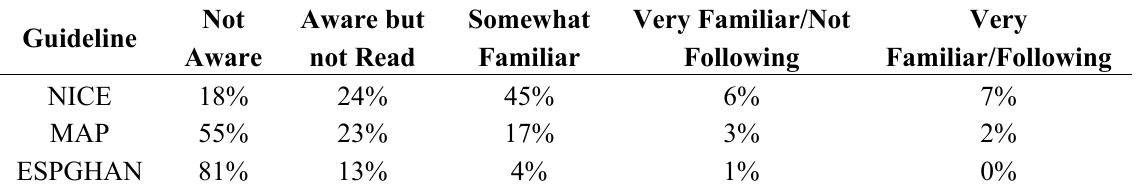
Table 2. Knowledge of current guidelines on CMPA.